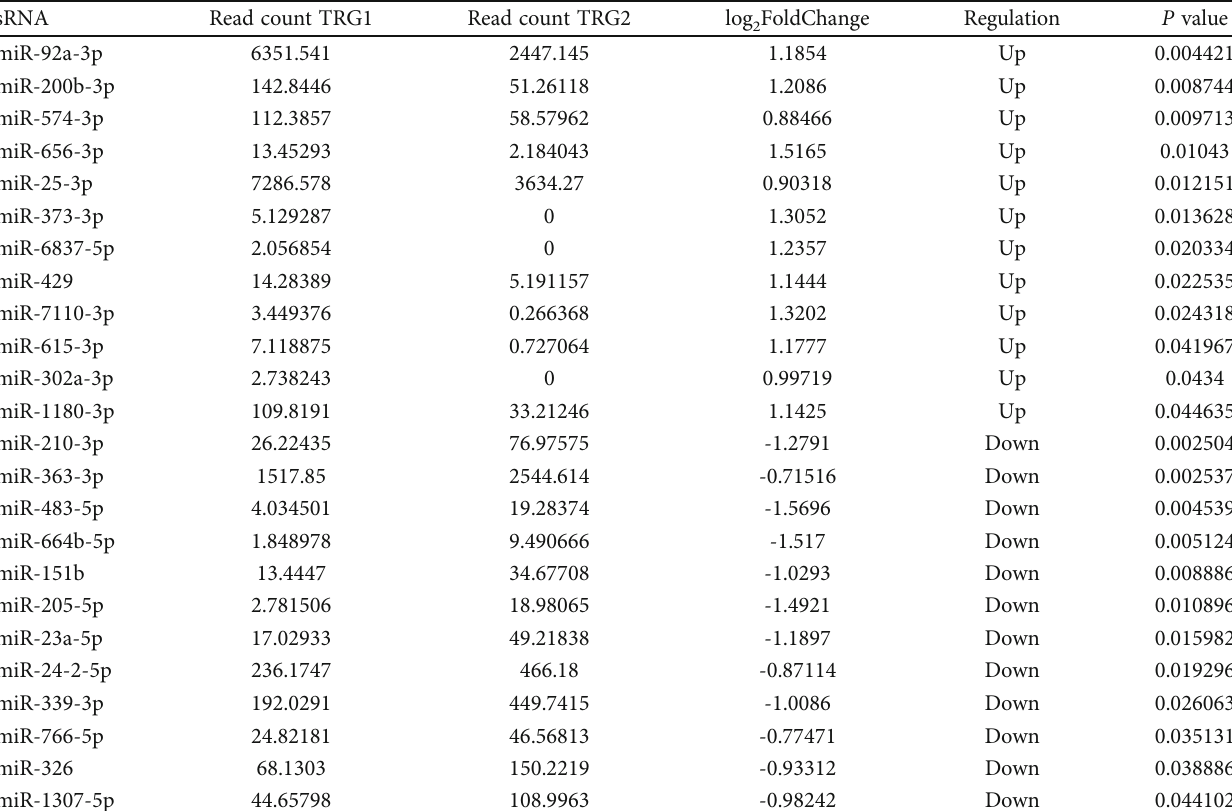
Table 2: Di ff erentially expressed miRNAs between the TRG1 group and TRG2 group before treatment. sRNA Read count TRG1 Read count TRG2 log